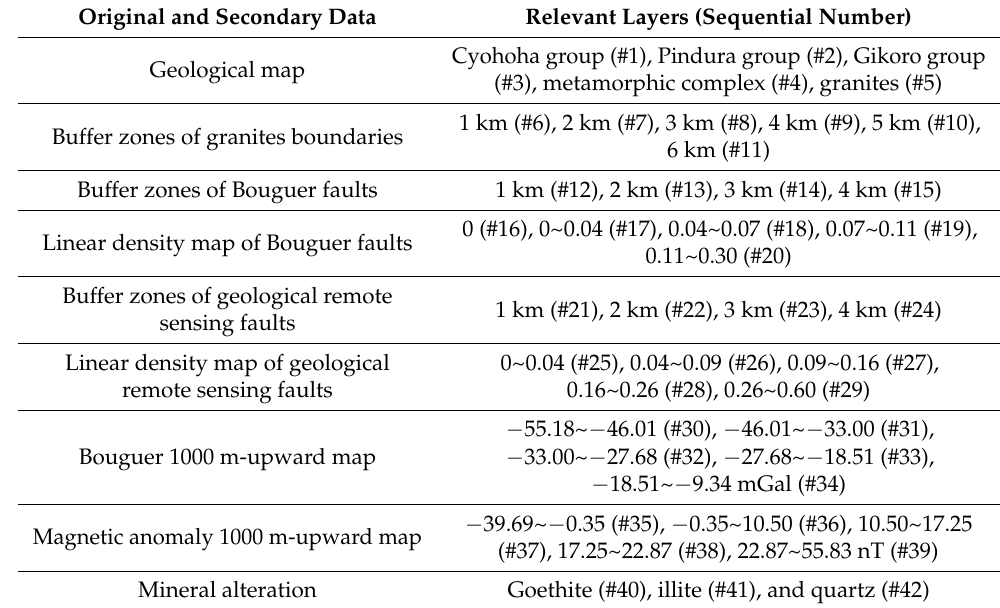
Table 2. Relevant layers of W, Sn, and Nb-Ta mineralization in